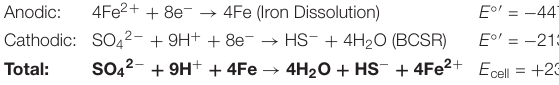
shift in corrosion potential leading to cathodic